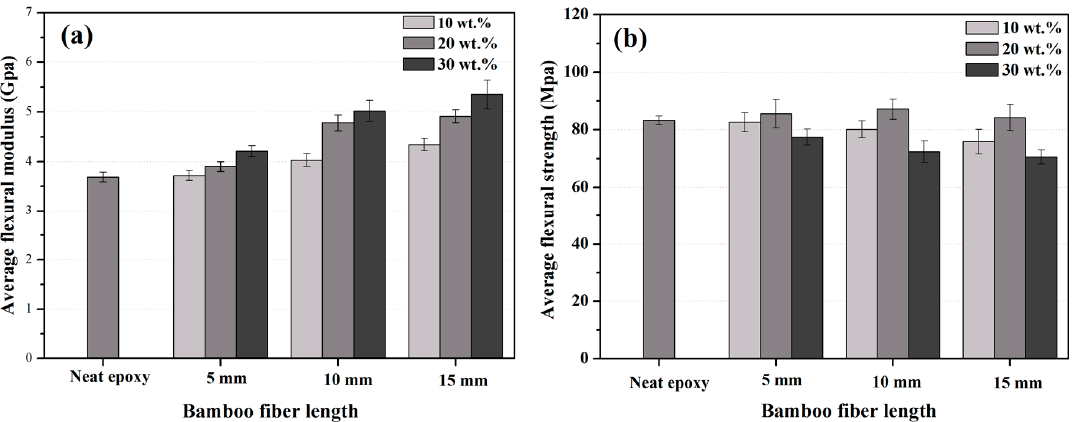
Figure 13. Average flexural strength ( a ) and modulus ( b ) of bamboo fiber composites compared to the neat epoxy.